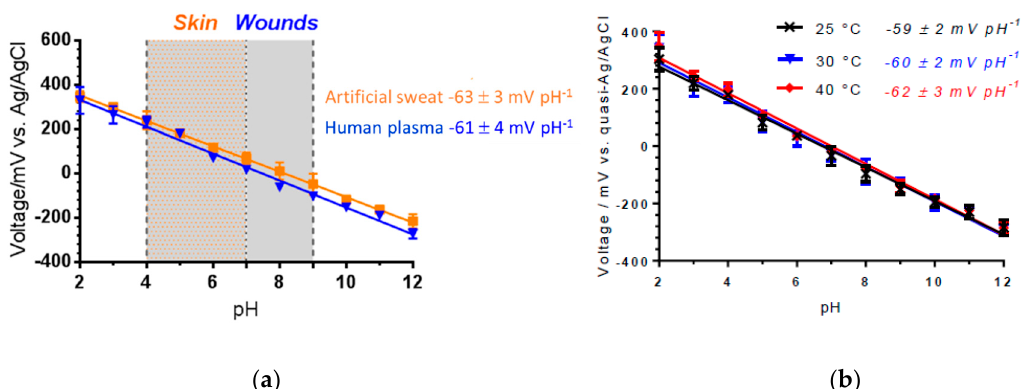
Figure 2. ( a ) Potentiometric response of Pani-PEDOT/MWCNT-cotton in pH adjusted artificial sweat and plasma. N = 3; ( b ) potentiometric response of Pani-PEDOT-MWCNT-cotton in buffered solutions of varying pH levels between 25 and 40 °C, n =